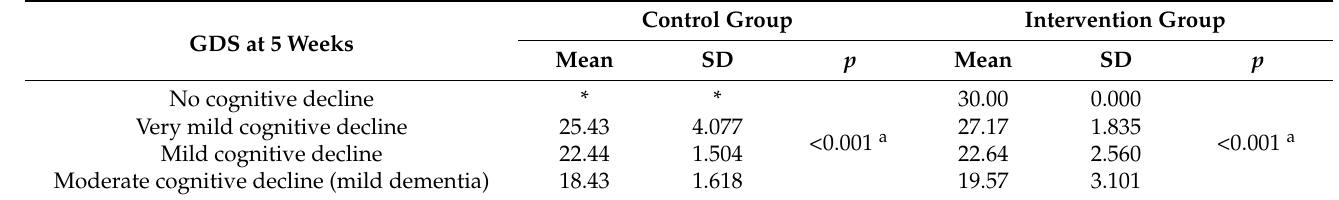
Table 4. Comparison between the control and the intervention group of the cognitive level after the intervention according to the severity of